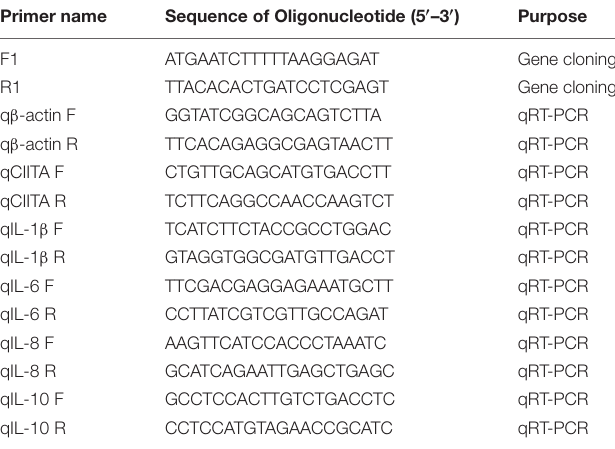
TABLE 1 | The primers